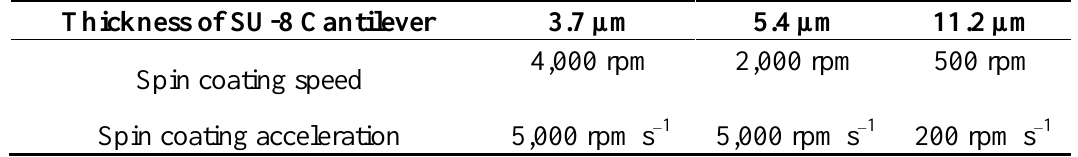
Table 2. Spin coating parameters for the first SU-8 layer depending on the cantilever thickness.